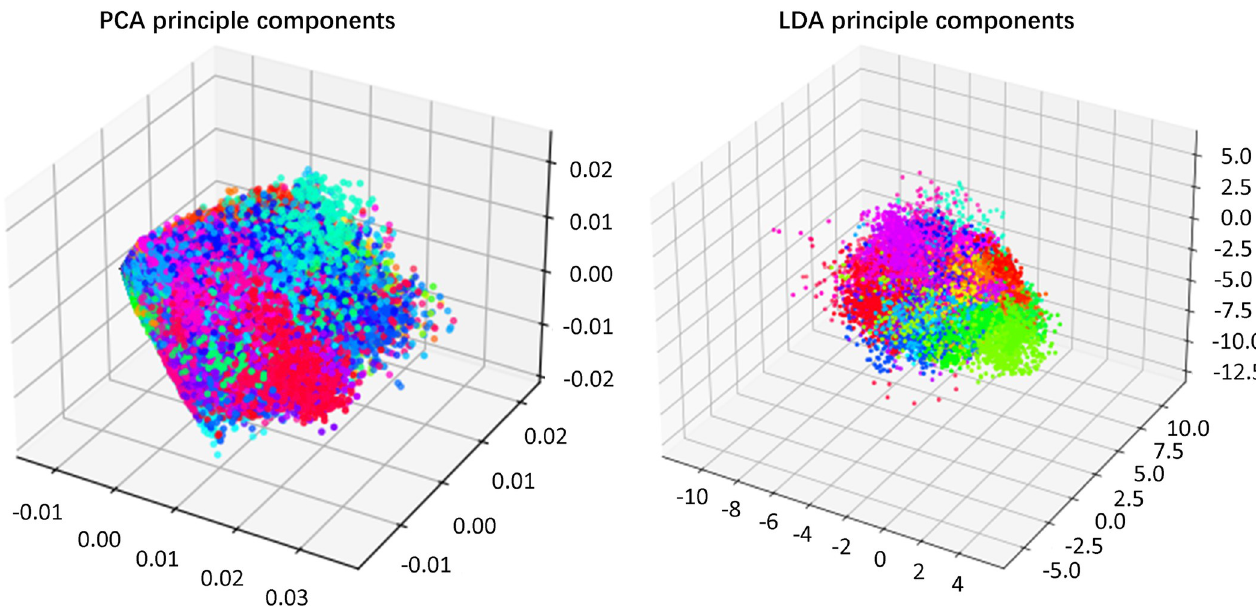
Fig 6. Principal components of DB1S1 obtained by the LDA and PCA. https://doi.org/10.1371/journal.pone.0262810.g006 LDA, are illustrated in Fig 6. Both of the clusters are hard to distinguish with groups of plots overlapping each other, meaning that the classifiers cannot find the differences among gestures efficiently; the LDA clusters have circular groupings and can be better represented by the clus- ter centroids, resulting in a higher classification accuracy of 77.60%. On DB2 data, the tradi- tional RCNN achieves 99.32% of accuracy, which is 8.34% higher than that of the ANN methods. CFF-RCNN increases the accuracy of the RCNN from 99.32% to 99.51%. On DB4 data, the LDA performs the best among all the tested machine learning methods, with an accu- racy of 94.79%. RCNN has a much higher accuracy of 99.25%. CFF-RCNN shows a slightly higher (99.29%) accuracy than RCNN. Accuracy results of RCNN, CFF-RCNN and models from other works can be found in Table 3. When classifying hand gestures with more than 50 gestures, CFF-RCNN shows better performance compared with machine learnings and other state-of-the-arts.